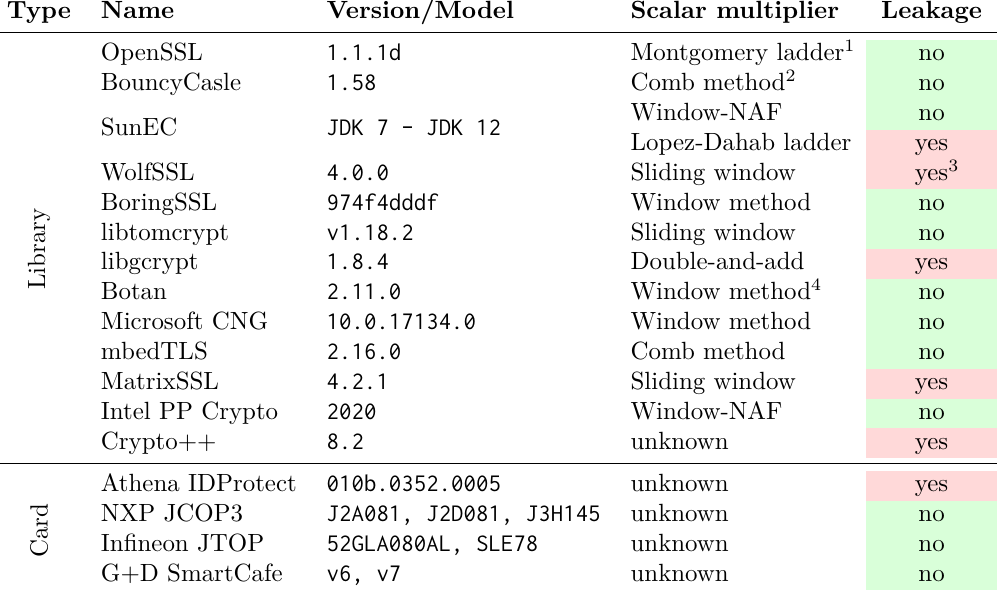
Table 1: Libraries and devices we analyzed with respect to their